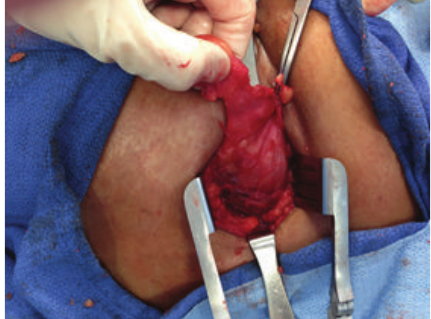
Figure1:AxialCTview:intercostalherniabetween10thriband11th rib at left midaxillary line (white arrow).